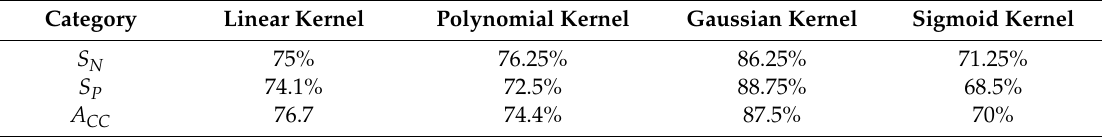
Table 4. Classification accuracy with di ff erent kernel